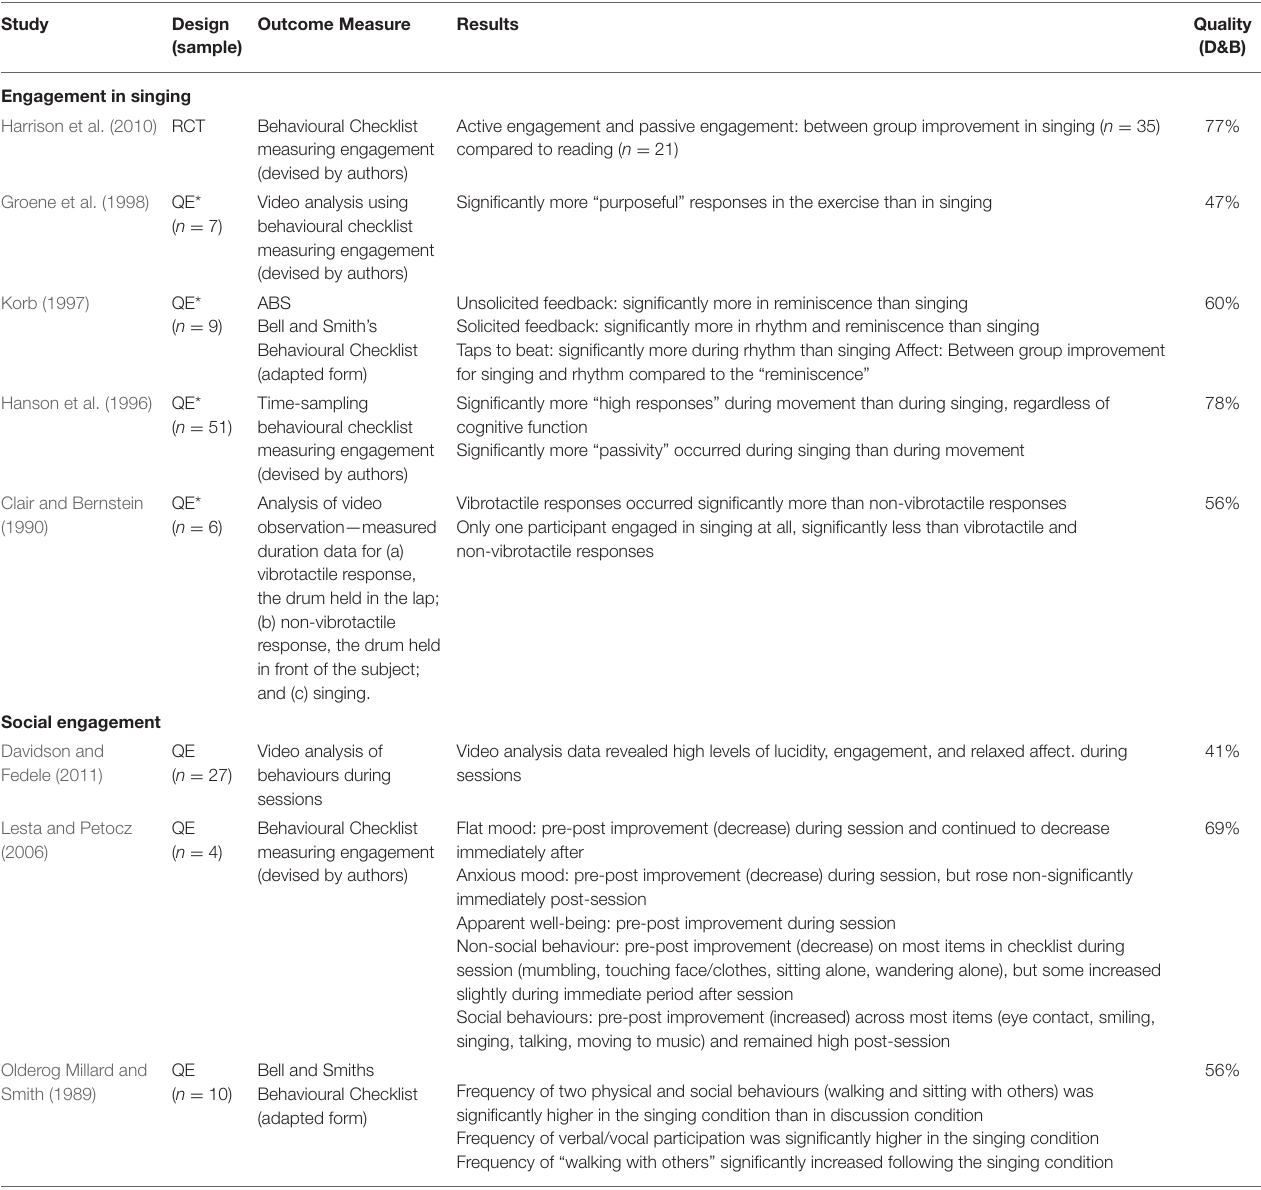
TABLE 6 | Overview of results of engagement